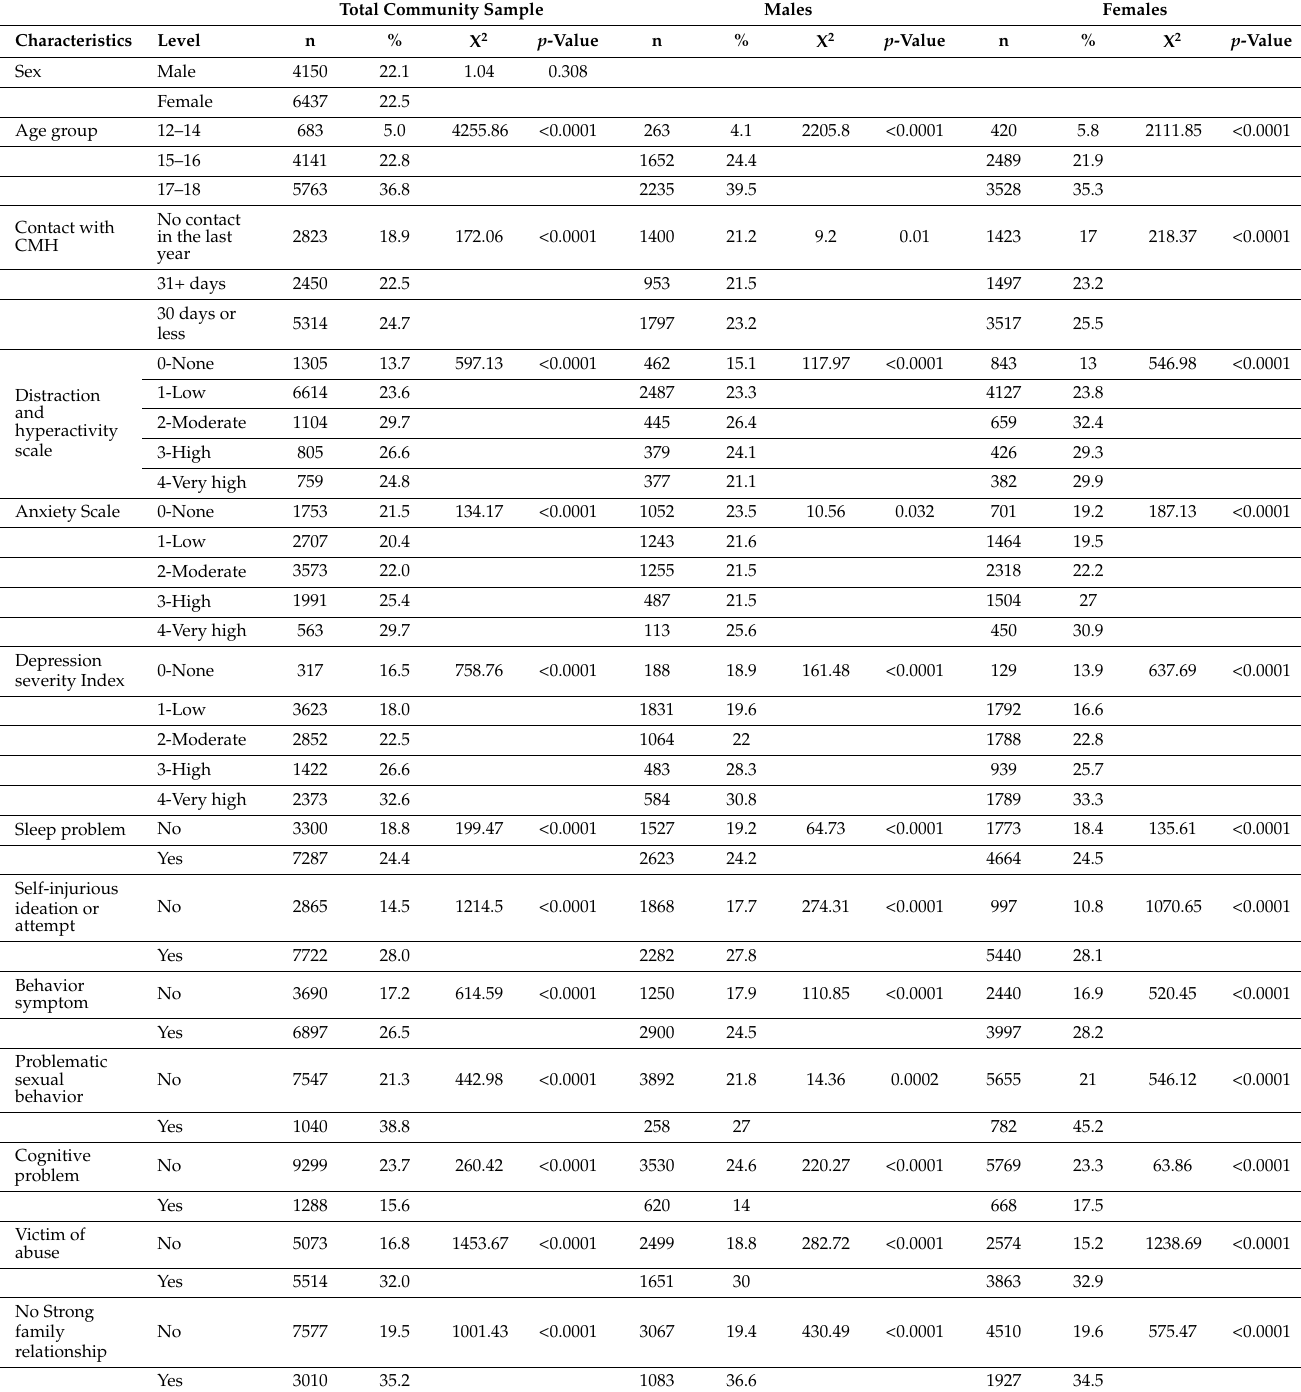
Table 3. The proportion of youth using substances in community settings, by gender. Total Community Sample Males